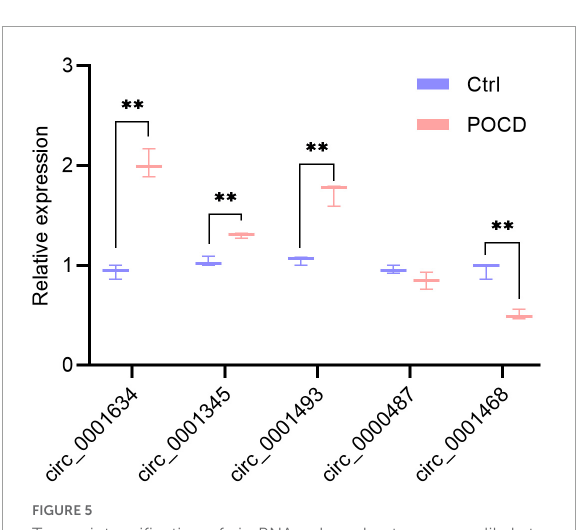
FIGURE5 Transcript verification of circRNAs whose host genes are likely to be associated with cognitive function. Target cirRNA expression were normalized to GAPDH expression ( (cid:49) Ct). Non-parametric test, ** p < 0.01 compared to the control group.